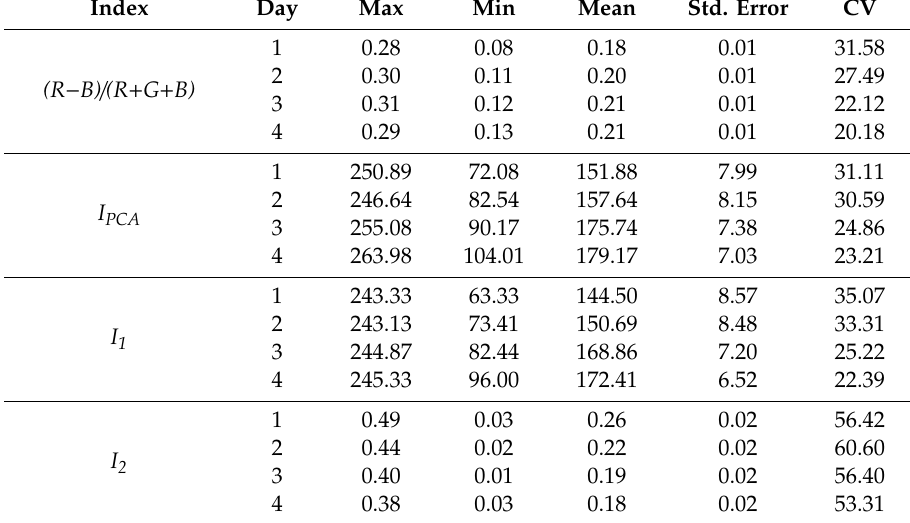
Table 7. Summary of descriptive statistics for ( R − B ) / ( R + G + B ), I PCA , I 1 and I 2 indices for daily values: minimum, maximum, mean, standard error and coe ffi cient of variation